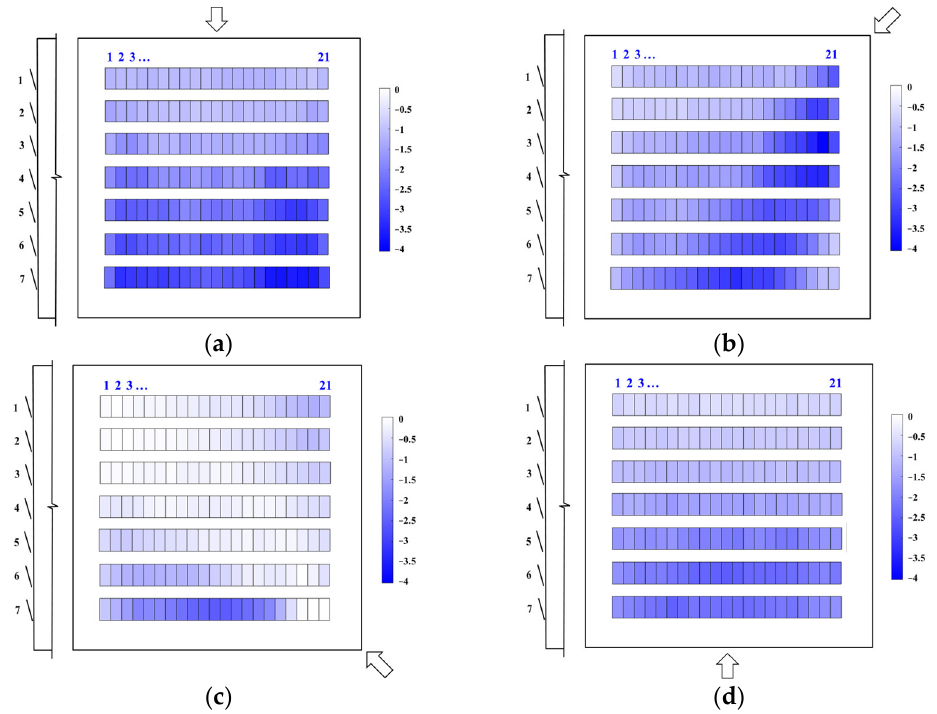
Figure 6. Contours of extreme wind loading coefficients of solar arrays corresponding to 78% percentile C 78% : ( a ) θ = 0°; ( b ) θ = 45°; ( c ) θ = 135°; and ( d ) θ = 180°.